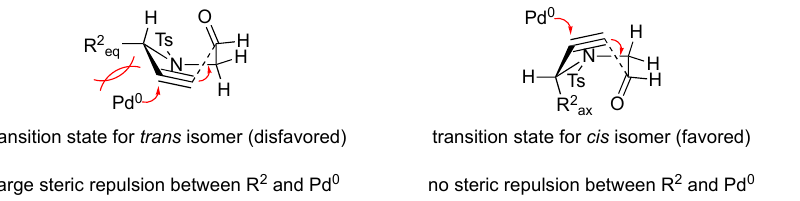
Figure 2. Diastereoselective cyclizations of 4f – h with a substituent at the propargyl position.